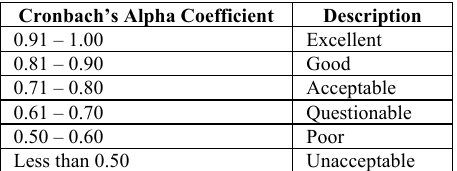
Table 3. Cronbach’s Alpha Coefficient